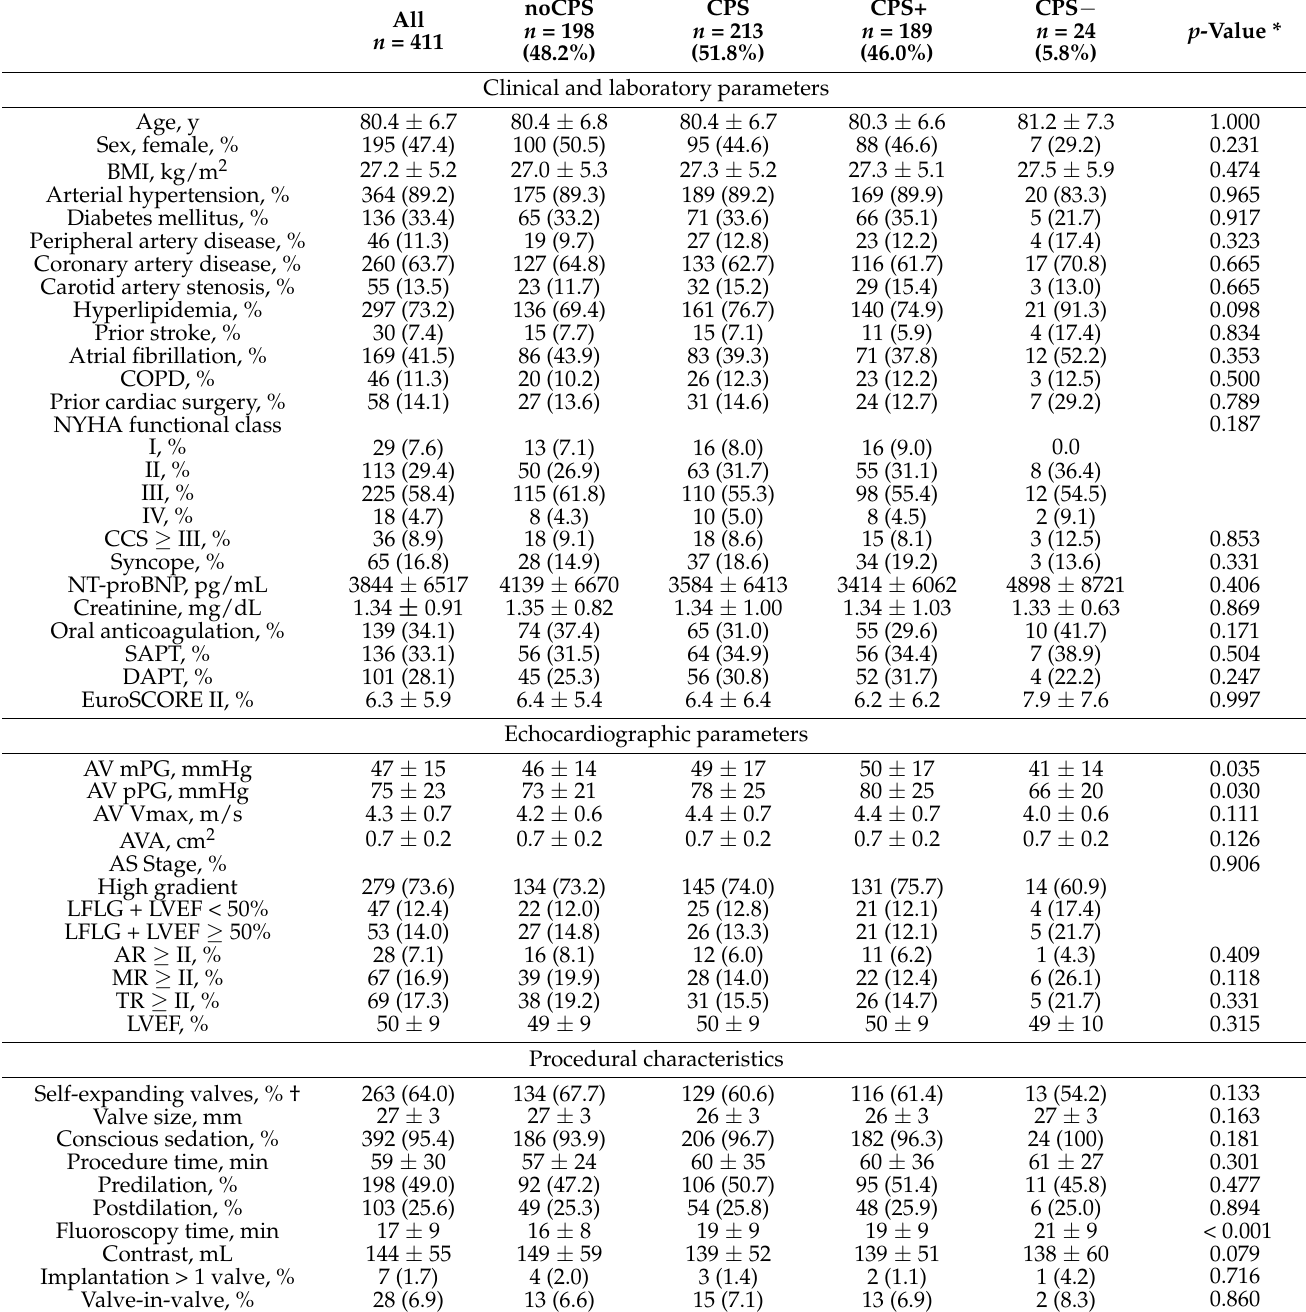
Table 1. Baseline